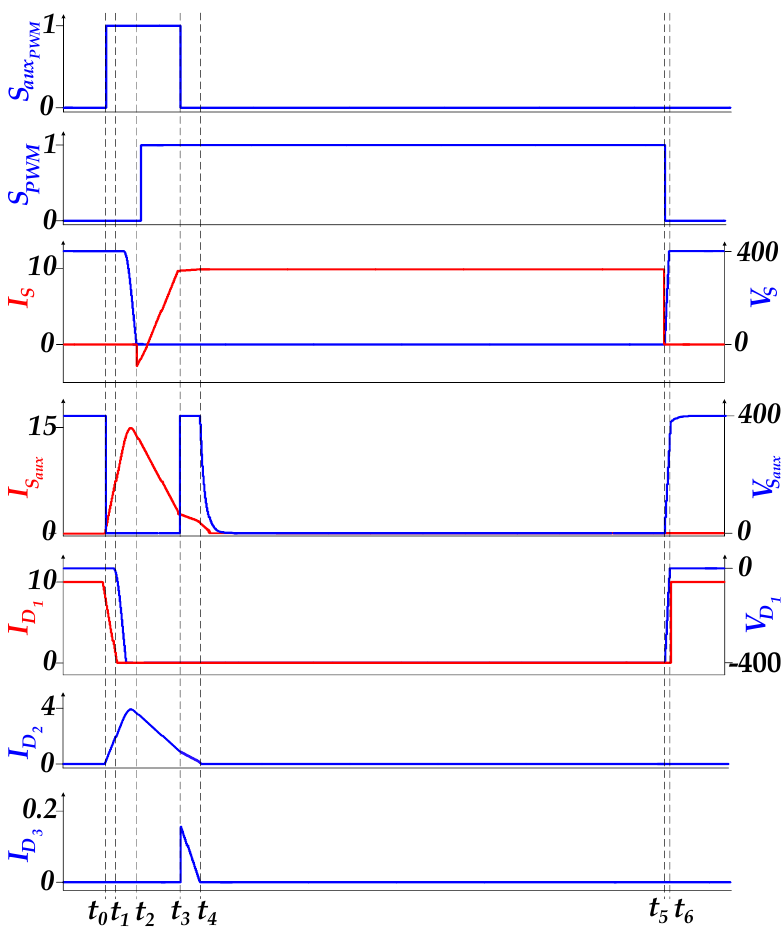
Figure 5. Simulated waveforms of the tandem converter.